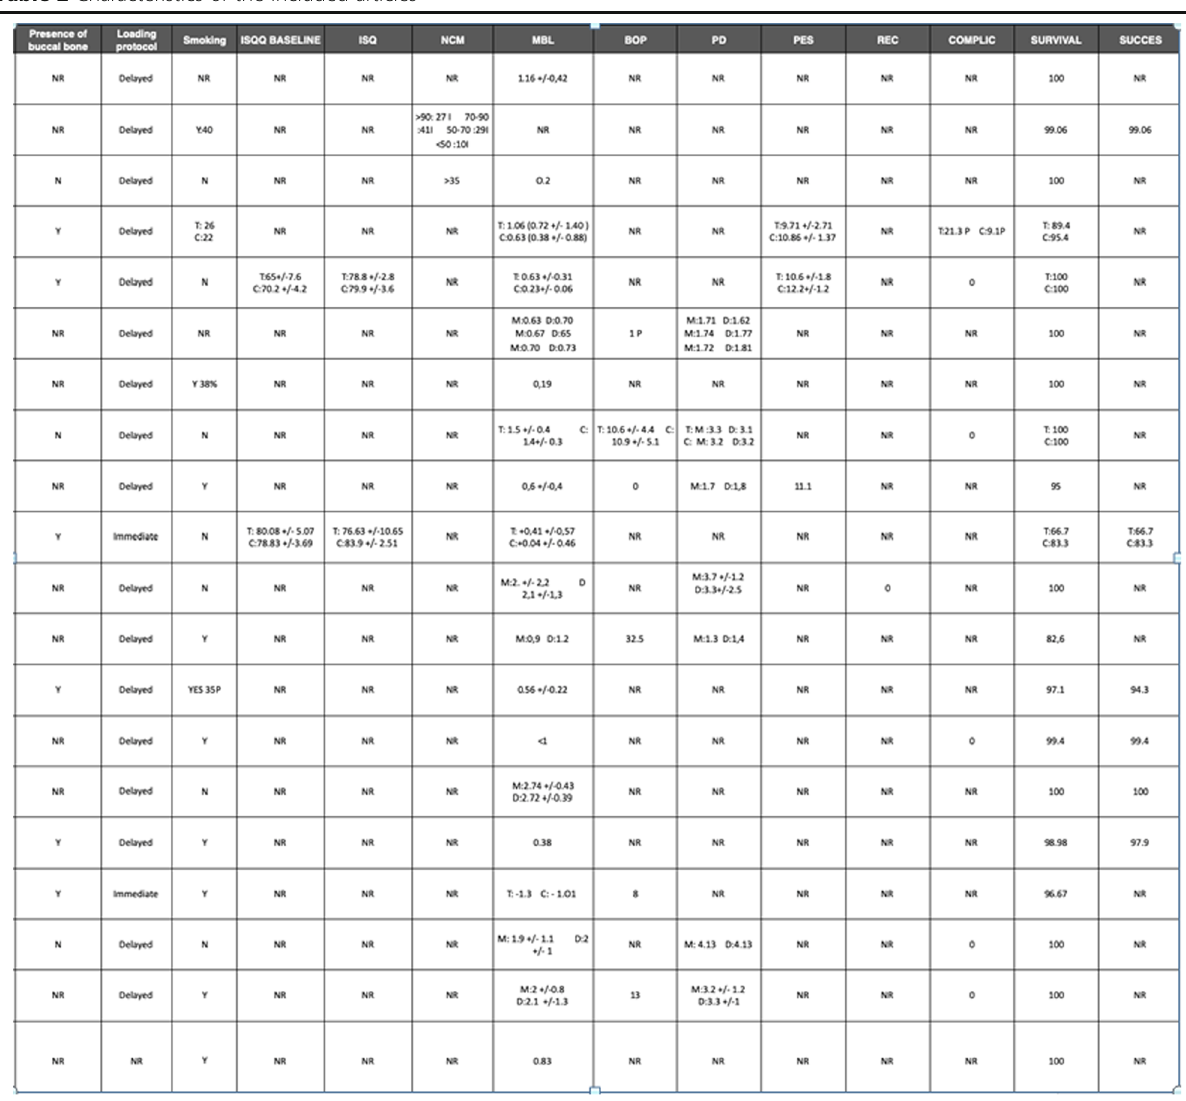
Table 2 Characteristics of the included